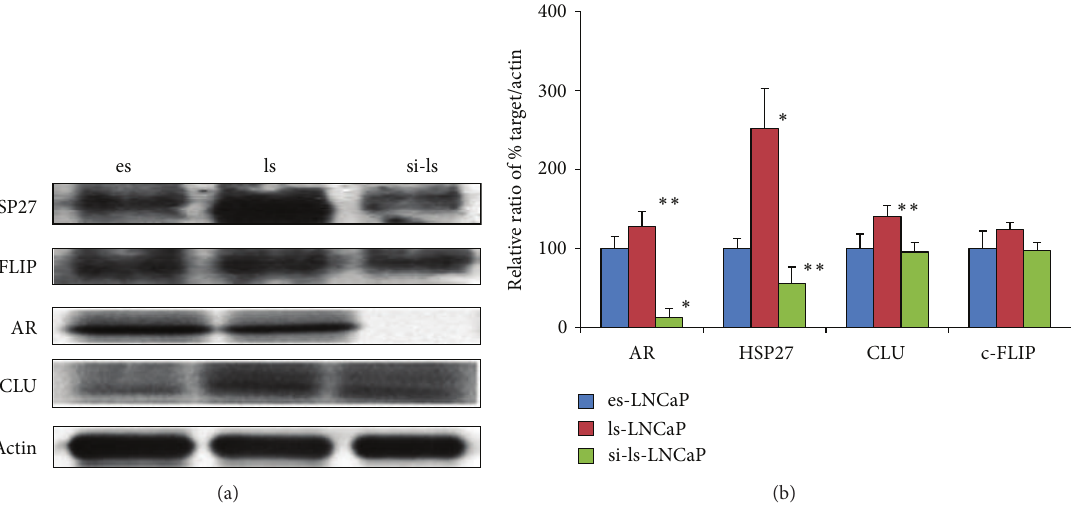
Figure 3: Electrophoretogram of immunoblot for androgen receptor, HSP27, c-FLIP, and clusterin expression at the es-, ls-, and the si-ls- LNCap